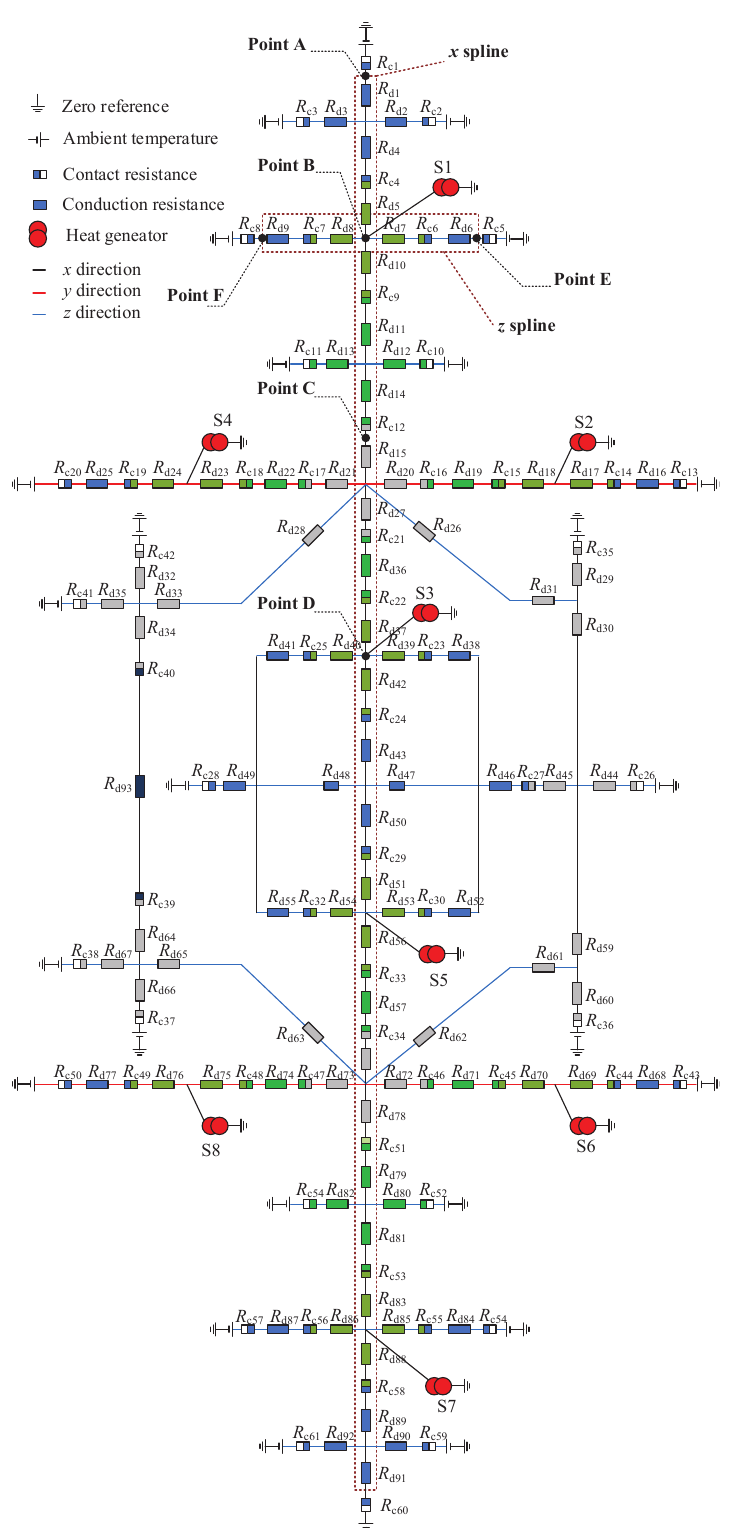
Figure 11. Thermal network of the whole